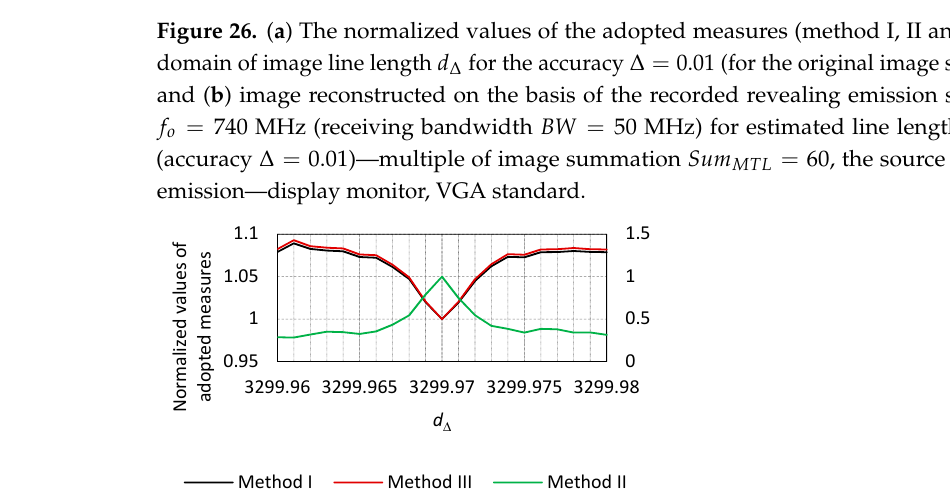
Figure 27. The normalized values of the adopted measures (method I, II and III) calculated in domain of image line length d ∆ for the accuracy ∆ = 0.001 (for the original image shown in Figure 7d).